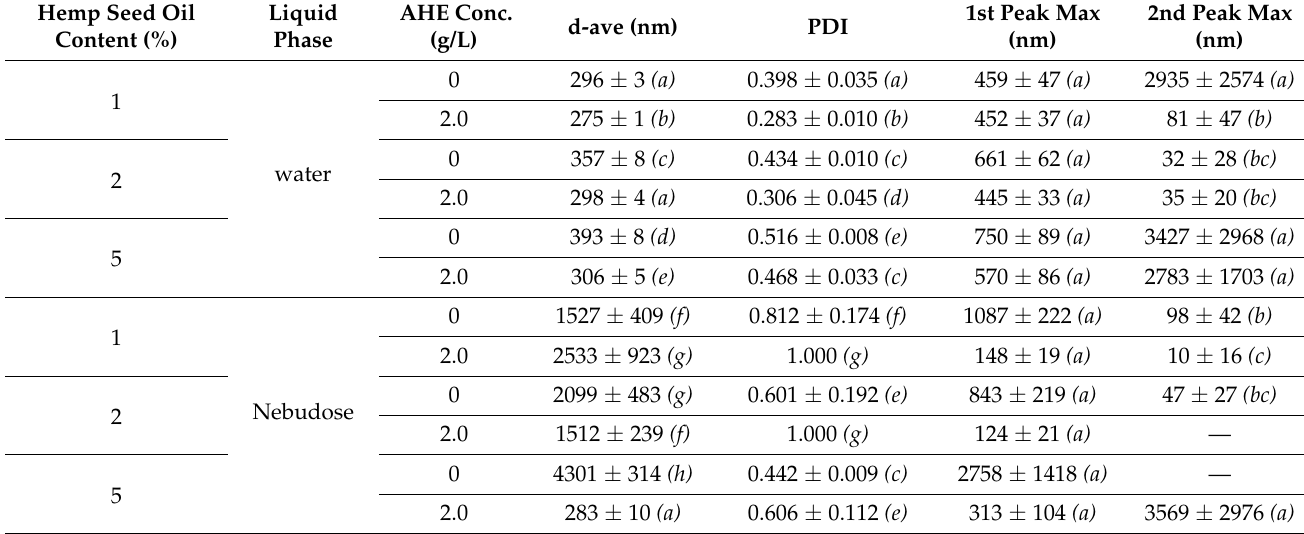
Table 3. Emulsion droplet size values (d-ave), PDI and average peaks